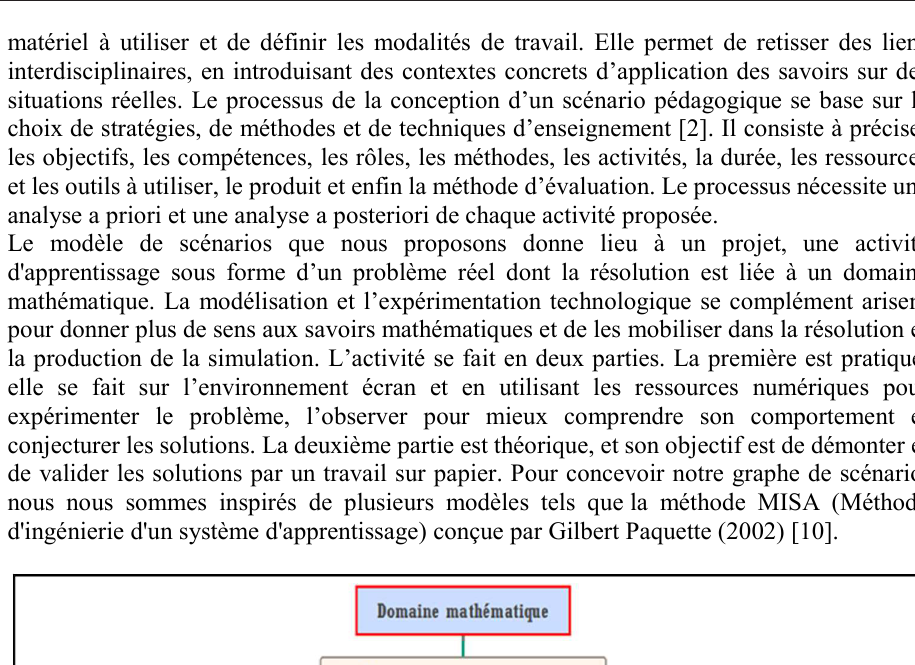
Fig. 2. Apport des ressources numériques.